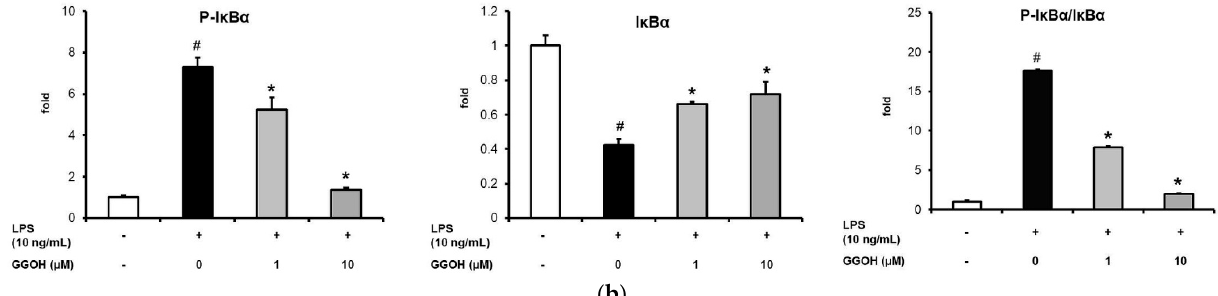
Figure 3. Inhibition of the expression of NF- κ B-related proteins by geranylgeraniol (GGOH). MG6 cells were pre-treated with GGOH for 24 h followed by LPS treatment (10 ng/mL) for 1 h. ( a ) Western blot images and quantification of phosphorylated TAK1, IKK α / β , and the p65 subunit of the NF- κ B signaling pathway after different LPS administration times. ( b ) Western blot images and quantification of phosphorylated and total TAK1, IKK α / β , p65, and I κ B α levels. The ratio of phosphorylated to total TAK1, IKK α / β , p65, and I κ B α proteins in the presence of GGOH pre-treatment is also shown. Total cell lysates were collected and subjected to Western blot analysis. Data are presented as the mean ± S.E.M, n = 3, normalized to the total protein levels detected based on α -tubulin. # p < 0.05 vs. untreated control; * p < 0.05 vs. LPS-only treated group or LPS-only at 0 min).